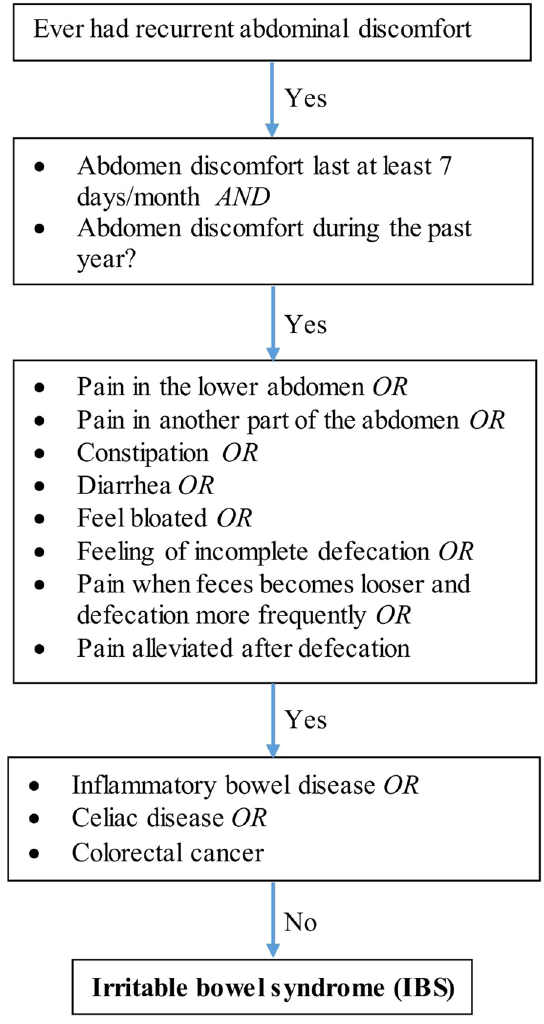
Fig. 2 De fi nition of irritable bowel syndrome in SALT Swedish twins. Self-reported symptoms used to de fi ne the presence of irritable bowel syndrome (IBS) in SALT Swedish